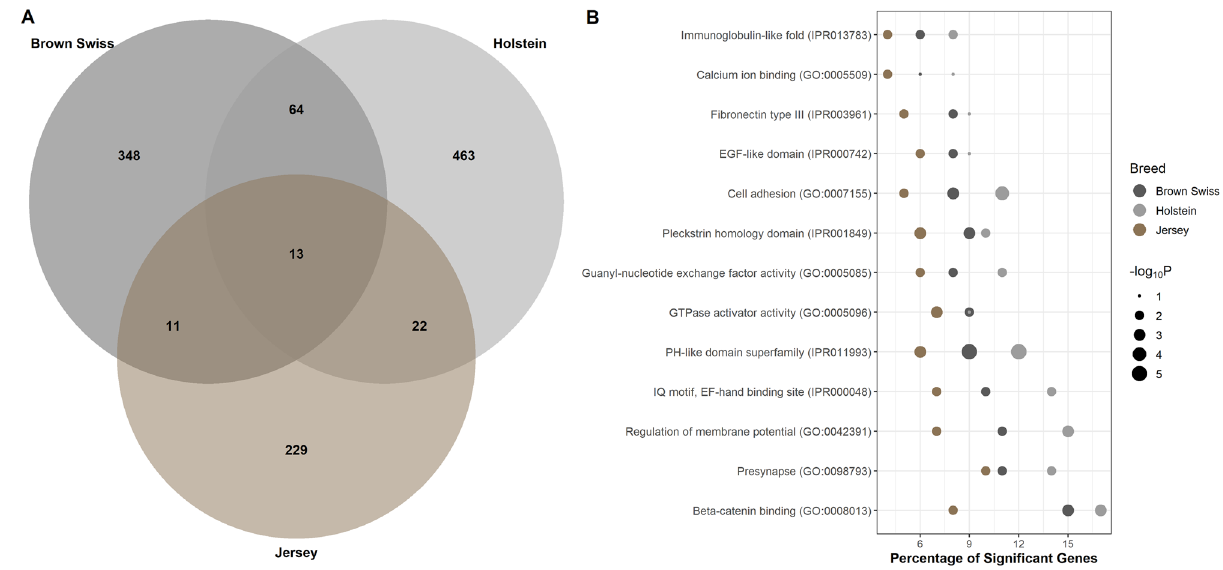
Figure 4. Functional gene-sets associated with male fertility across different dairy breeds. ( A ) Venn diagram showing the number of gene-sets significantly associated with sire conception rate in Brown Swiss, Holstein, and Jersey cattle. ( B ) Significant gene-sets identified in the three dairy breeds under study. The y-axis displays the names of the gene-sets, the size of the dots represents the significance of the enrichment (− log 10 P -value, Fisher’s exact test) and x-axis represents the percentage of significant genes in each